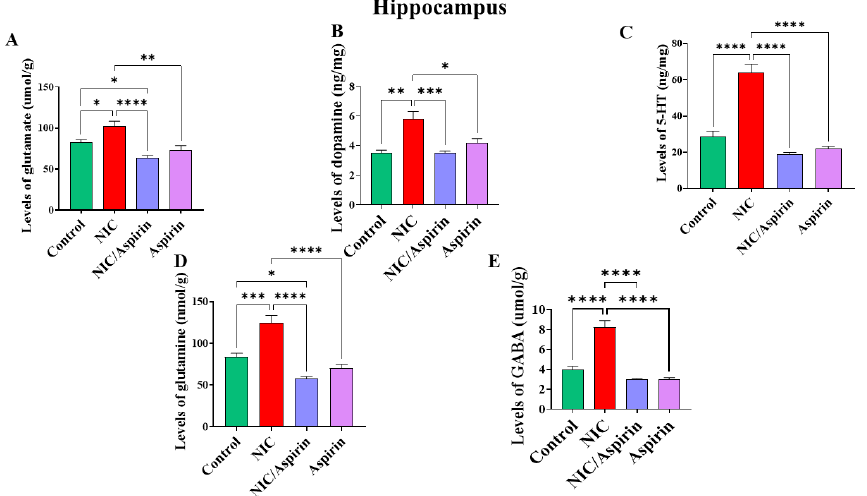
Figure 5. Tissue content of neurotransmitters after tobacco cigarette smoke exposure and aspirin treatment in the hippocampus. ( A ) Glutamate; ( B ) dopamine; ( C ) serotonin; ( D ) glutamine; and ( E ) GABA. Data expressed as mean ± SEM (* p < 0.05, ** p < 0.01, *** p < 0.001, **** p < 0.0001; n = 5 for ± SEM (* p < 0.05, ** p < 0.01, *** p < 0.001, **** p < 0.0001; n = 5 each group). ( E ) GABA. Data expressed as mean for each